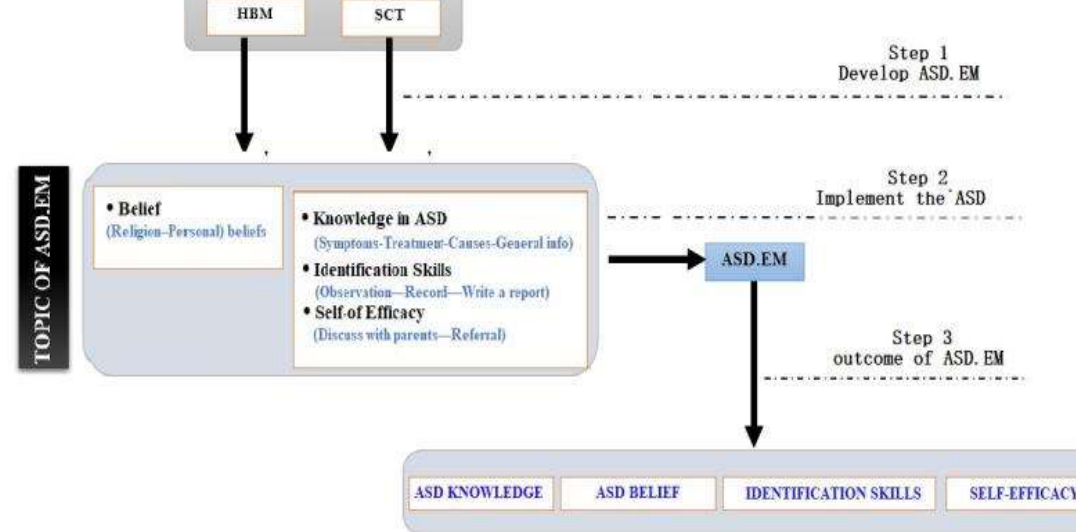
Figure 2. A conceptual framework for identifying children with autism spectrum disorder (ASD).